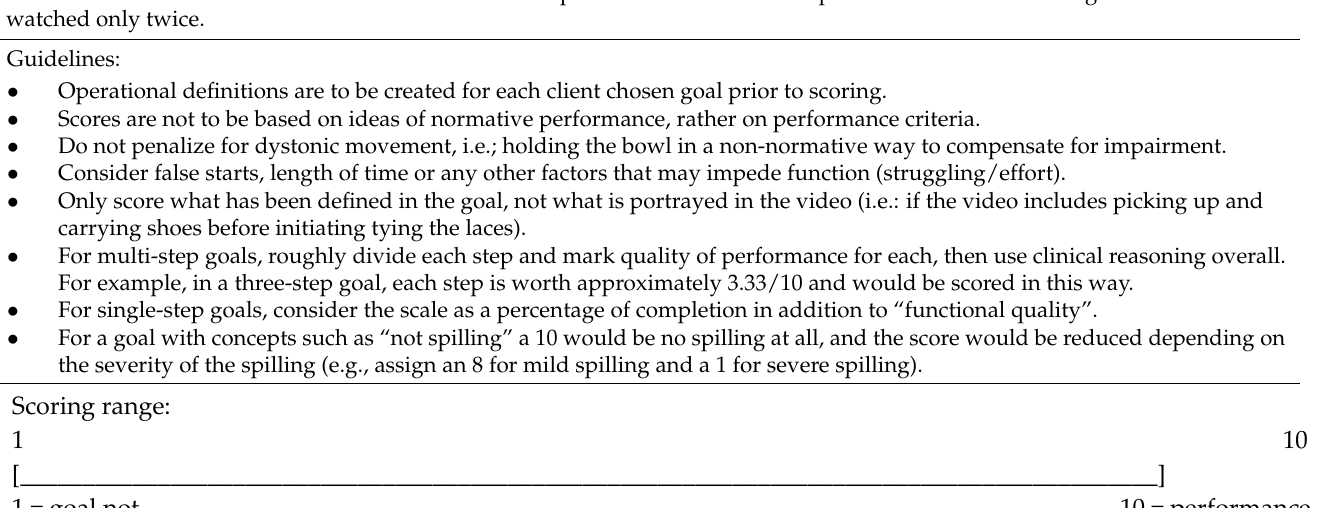
Table 2. PQRS-I Rating Scale.